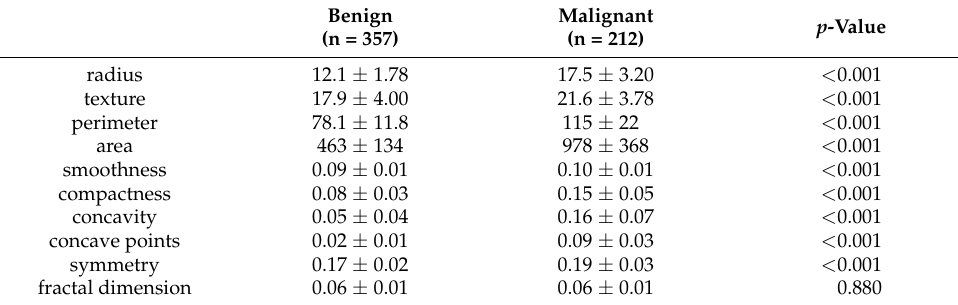
Table 5. Breast Cancer Wiscosin: features average by diagnosis.